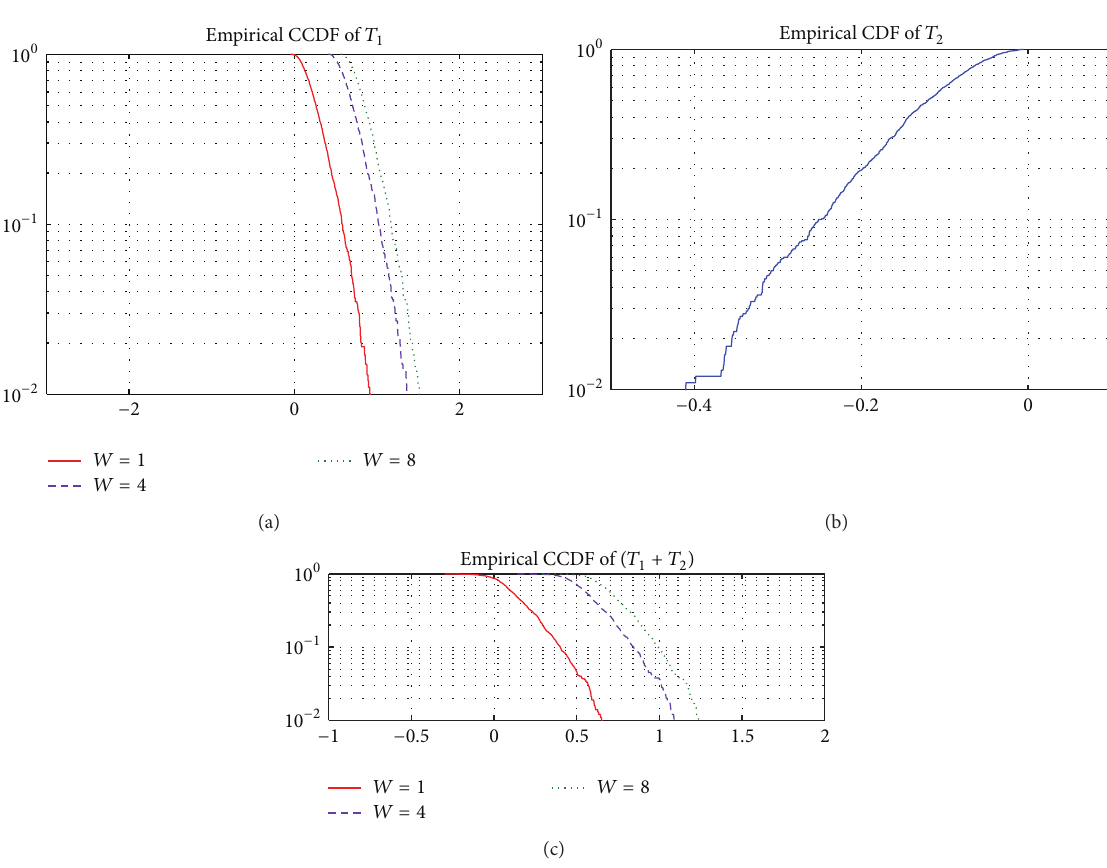
Figure 4: Statistical distributions (note: 𝑇 2 is independent of 𝑊